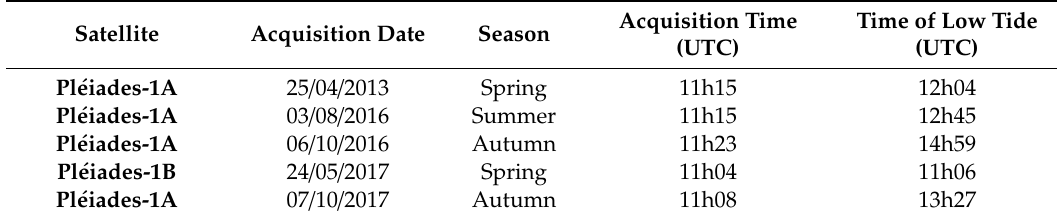
Table 1. Pl é iades satellite data set